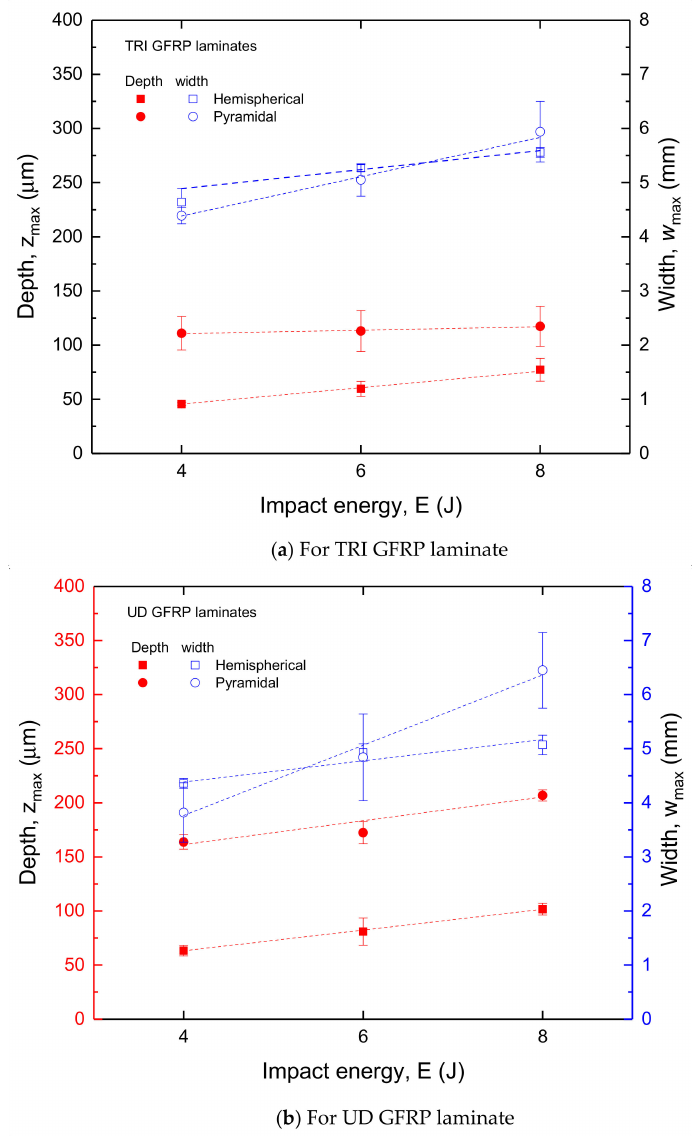
Figure 4. Maximum depth and width of the pyramidal and hemispherical indent ( a ) for the TRI ( b ) UD GFRP laminates. Table 2. Dimension of impact indent profiles created in the UD and TRI